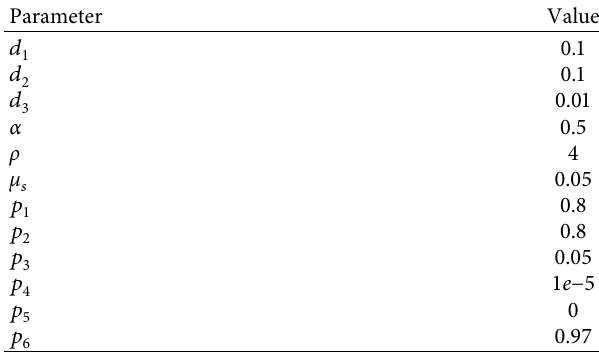
Table 2: Controller parameters.